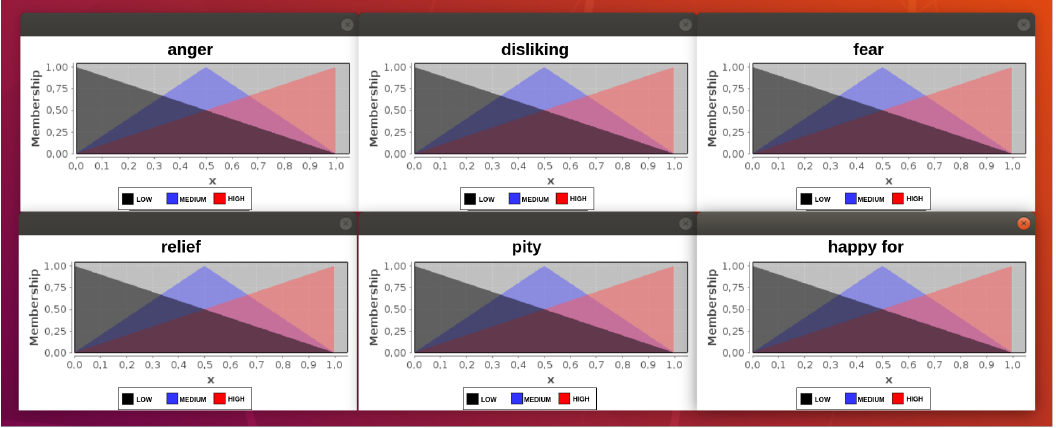
Figure 4. Fuzzy values of the input variables.